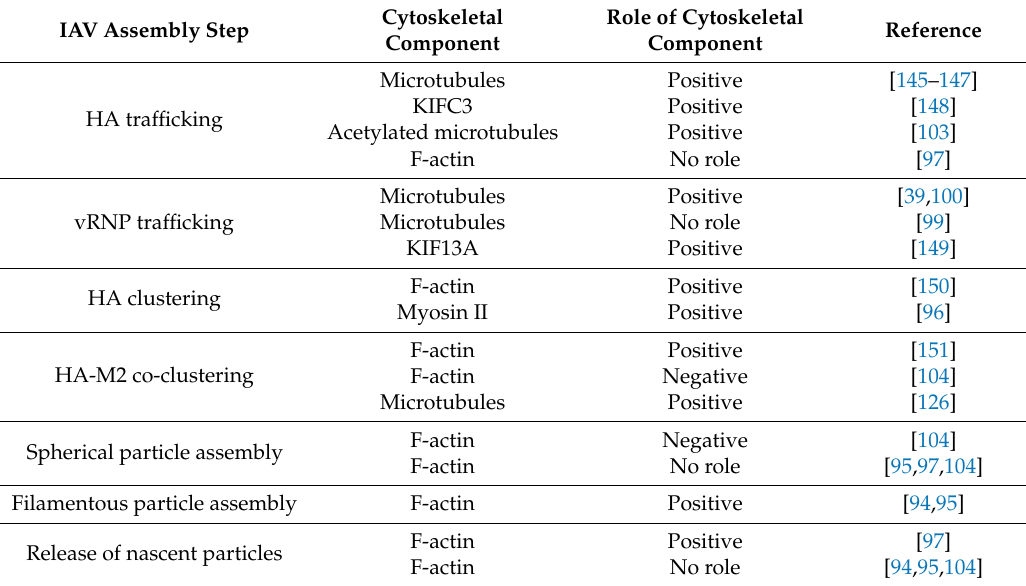
Table 1. Roles of specific cytoskeletal components at different steps of IAV